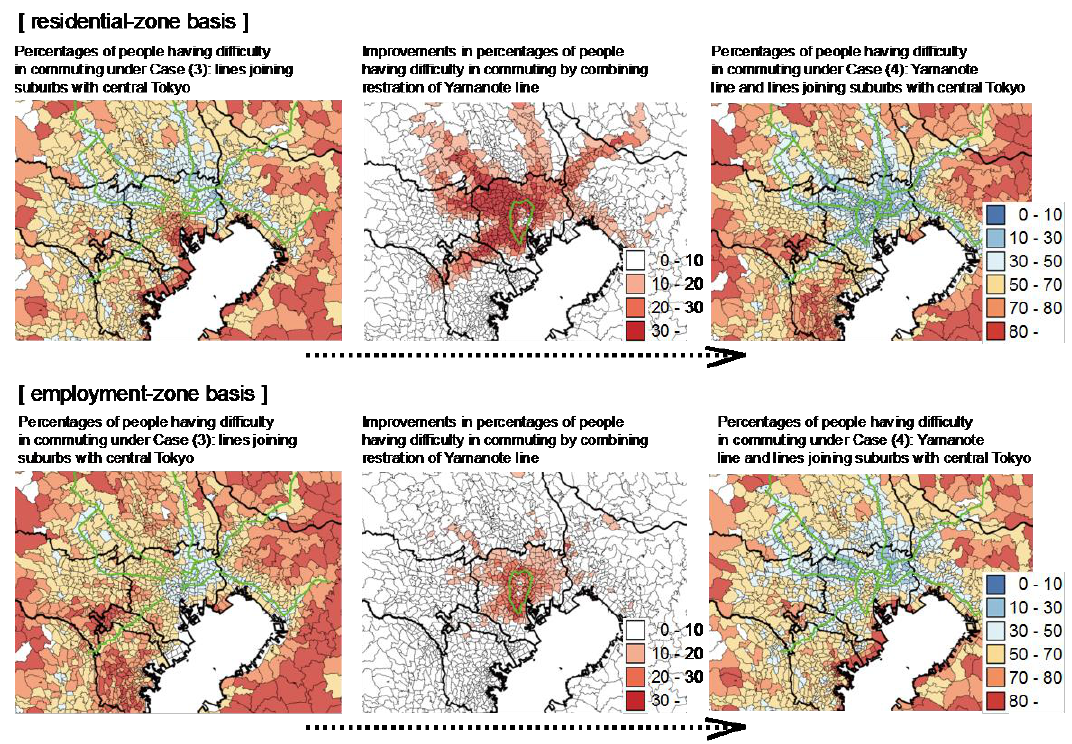
Figure 19. Improvements in percentages of commuting difficulty following restoration of transport services by residential and employment